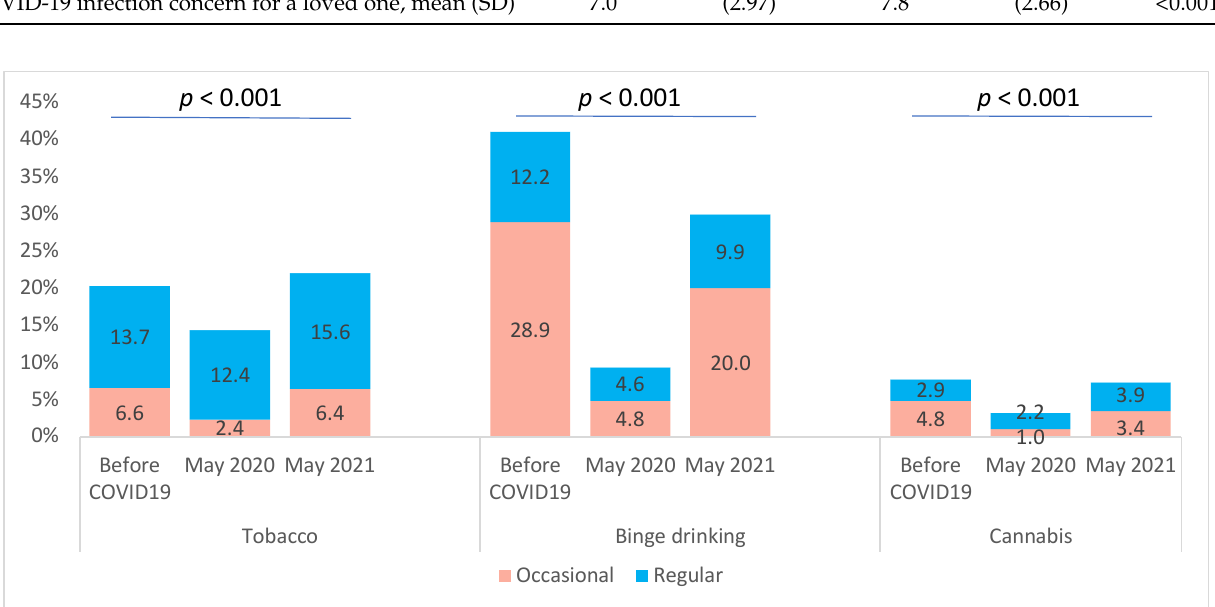
Figure 1. Tobacco smoking, binge drinking, and cannabis use of university students before the